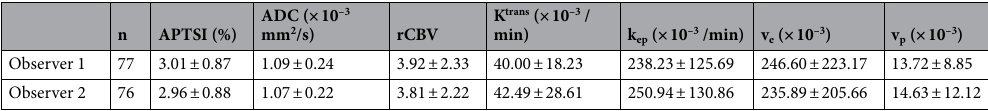
Table 1. Mean values of quantitative MR imaging parameters.